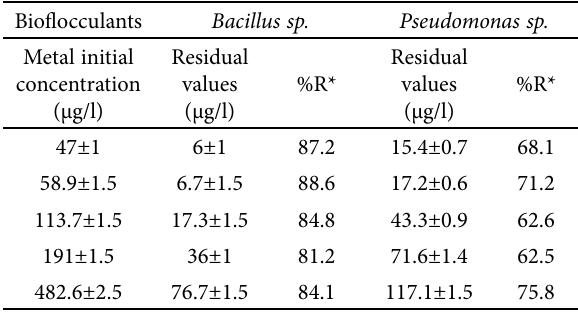
Table 2. The efficiency of bio-flocculants of Bacillus sp.